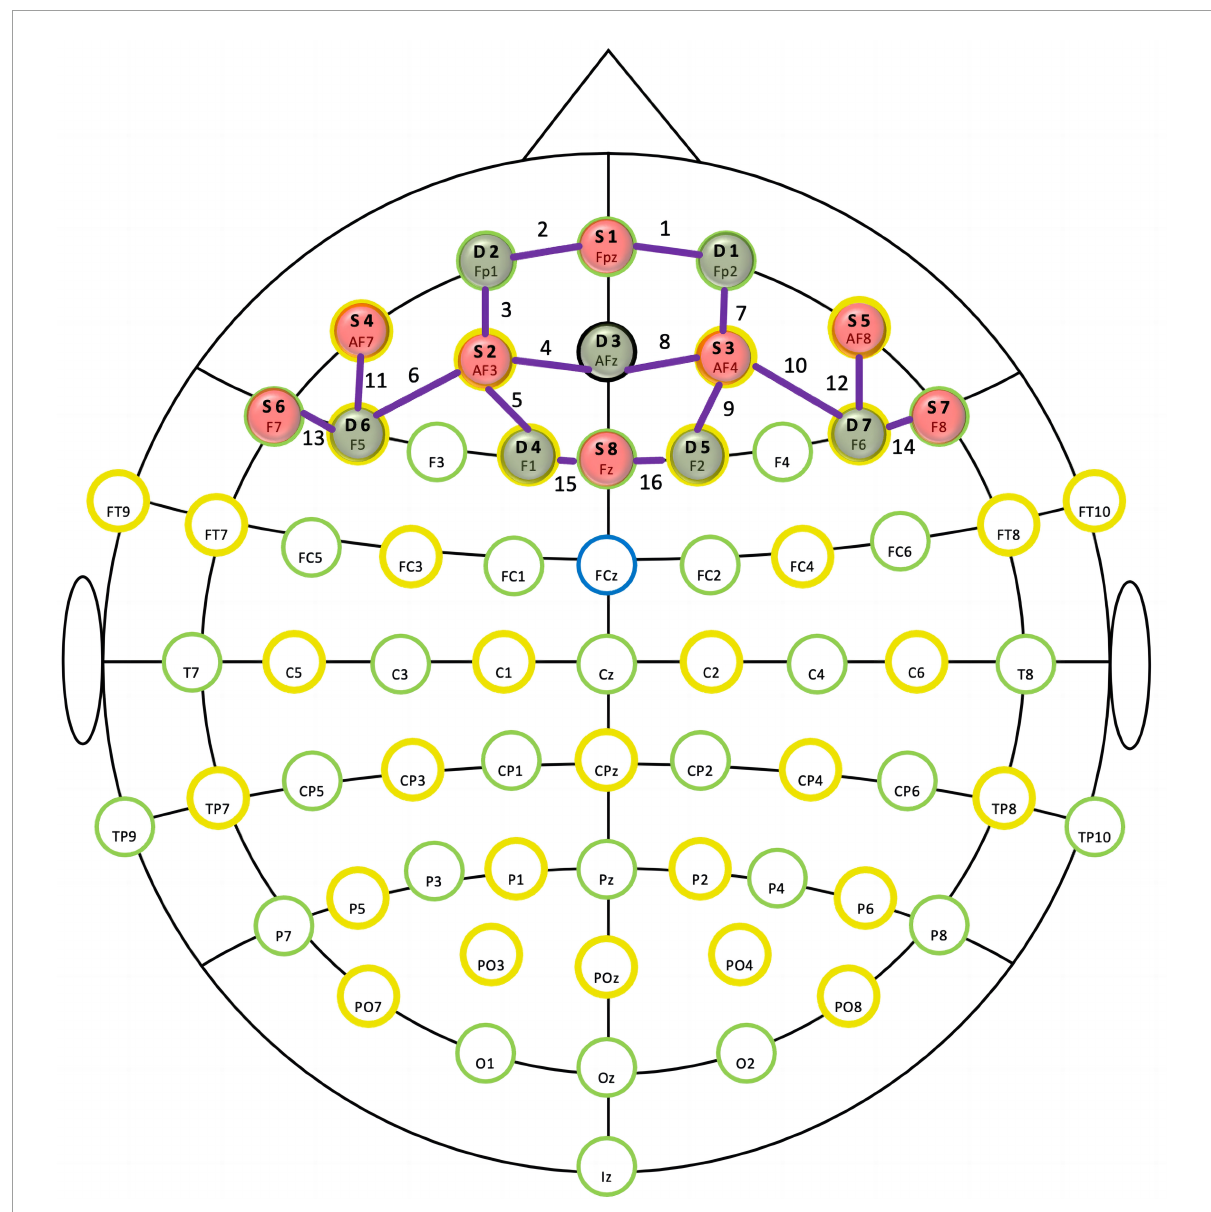
FIGURE1 In the functional near-infrared spectroscopy (fNIRS) montage, sources (S) and detectors (D) were situated according to the international 10–20 system. The purple lines and numbers represent channels.